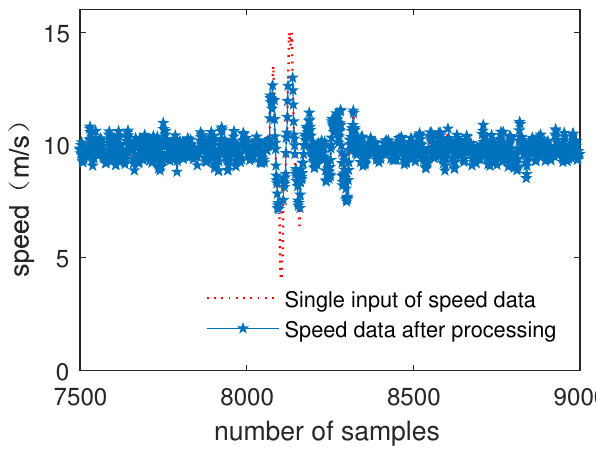
Figure 7. Single input of speed data and processed data.